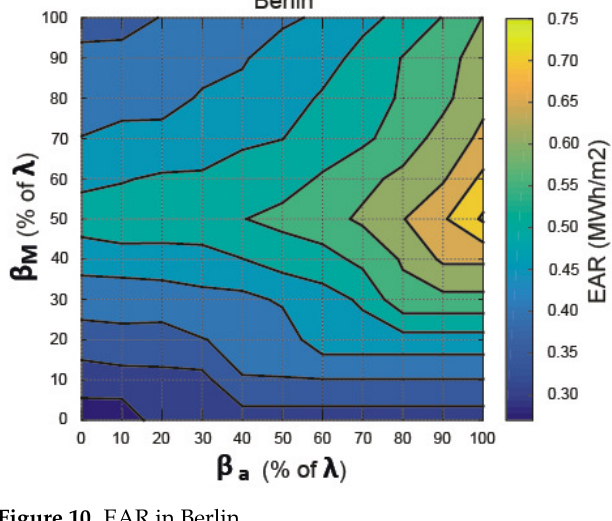
Figure 10. EAR in Berlin.